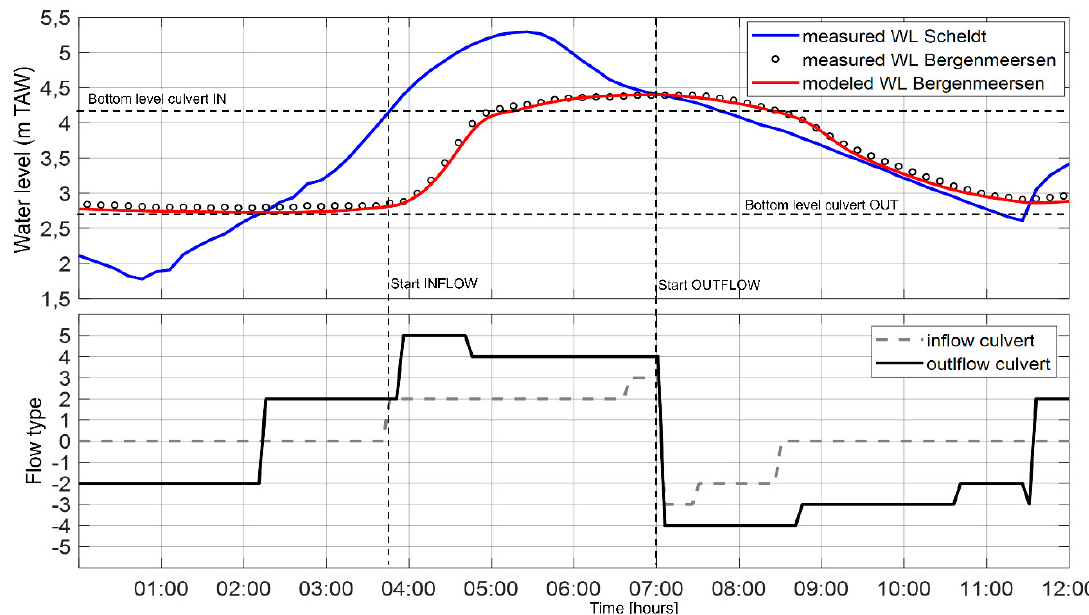
Figure A2. Different flow types for flow through culverts during spring tide at FCA with CRT Figure A2. Di ff erent flow types for flow through culverts during spring tide at FCA with Bergenmeersen. CRT